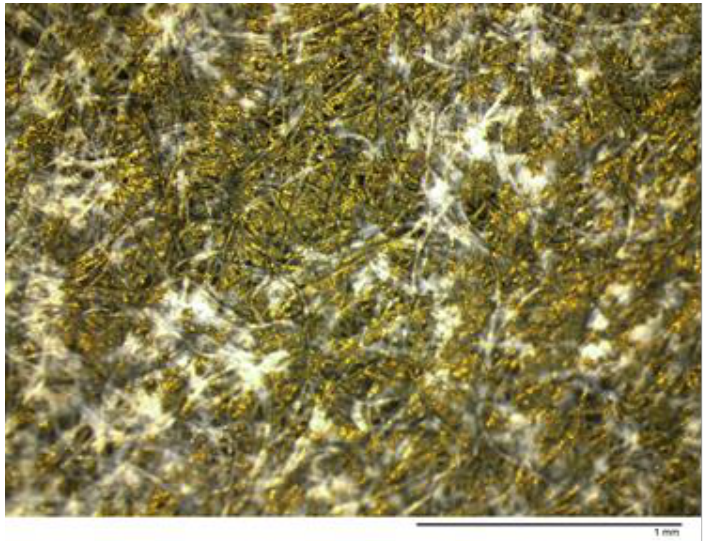
Figure 4. View of the precipitated gold nanoparticles under a magnifier.